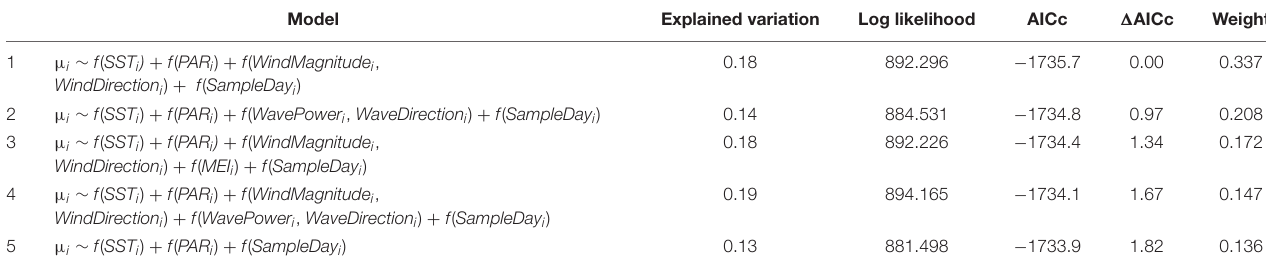
TABLE 2 | Five models resulting from a comparison of models investigating (cid:49) chl representing all possible predictor combinations within (cid:49) AICc < 2 of the lowest AICc model.